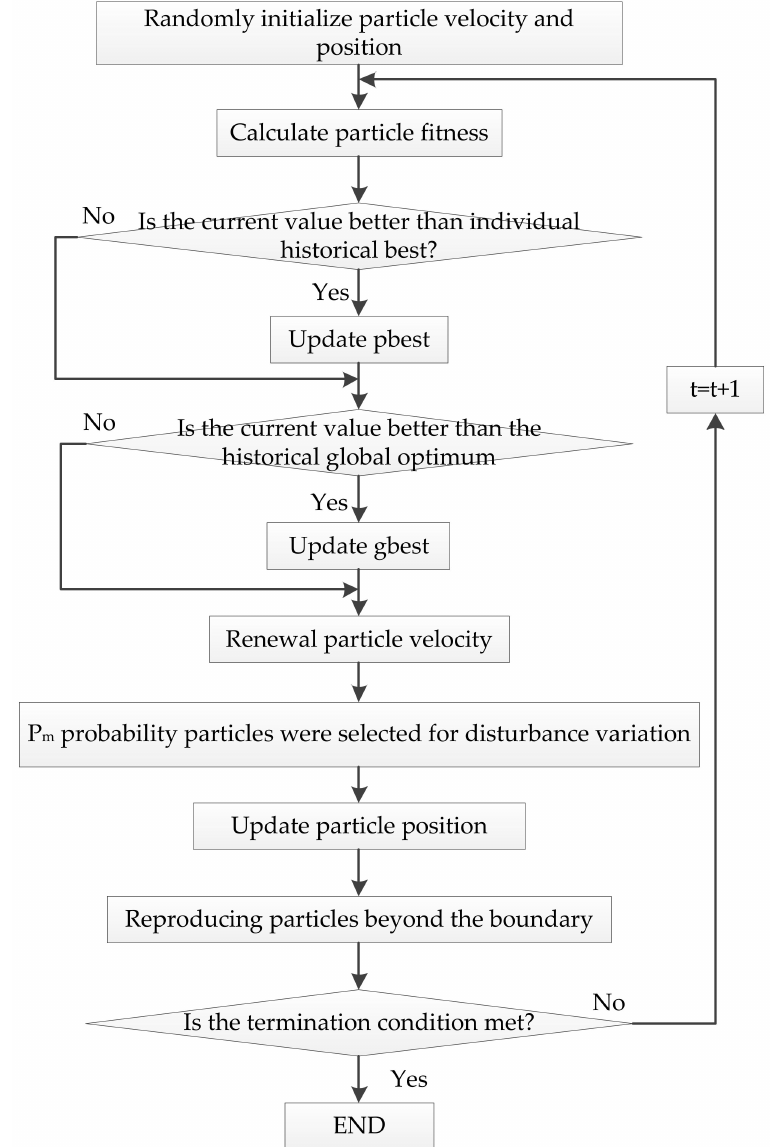
Figure 2. Algorithm